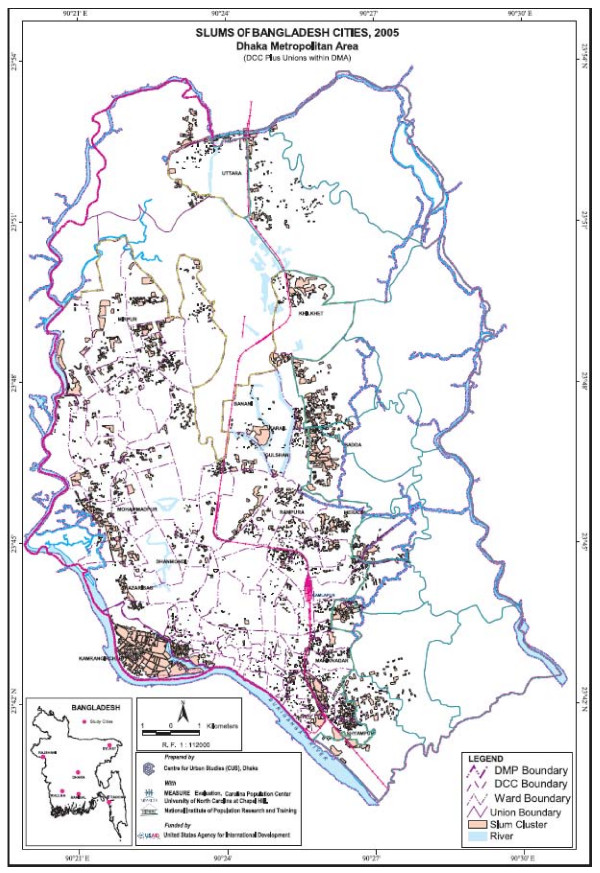
Slum map of Dhaka.